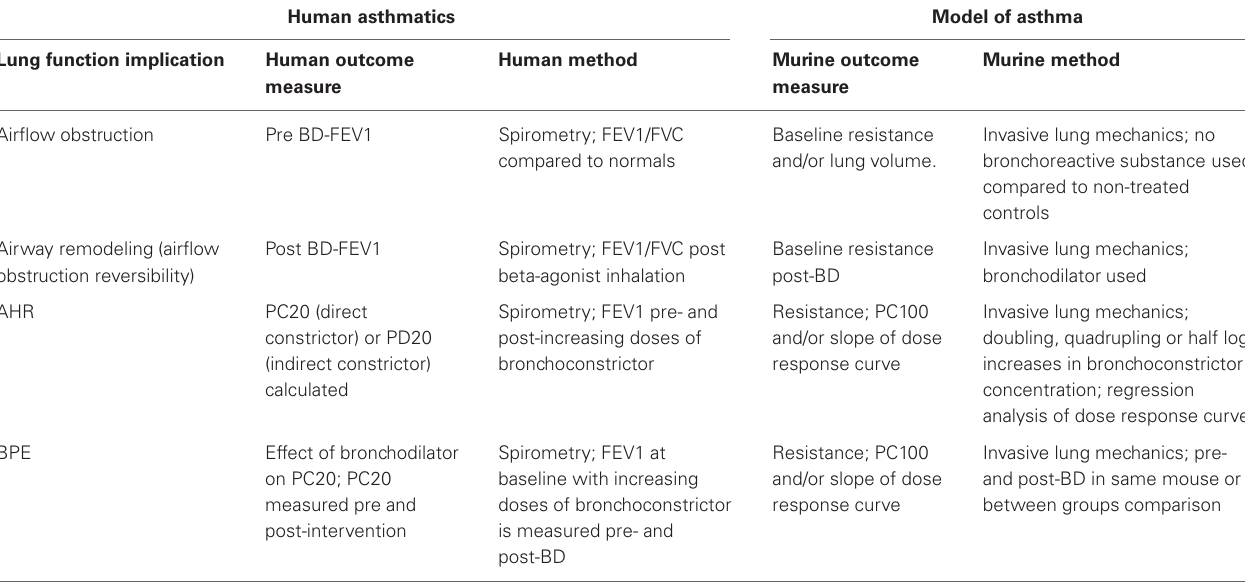
Table 2 | Comparing lung mechanics measures in humans and